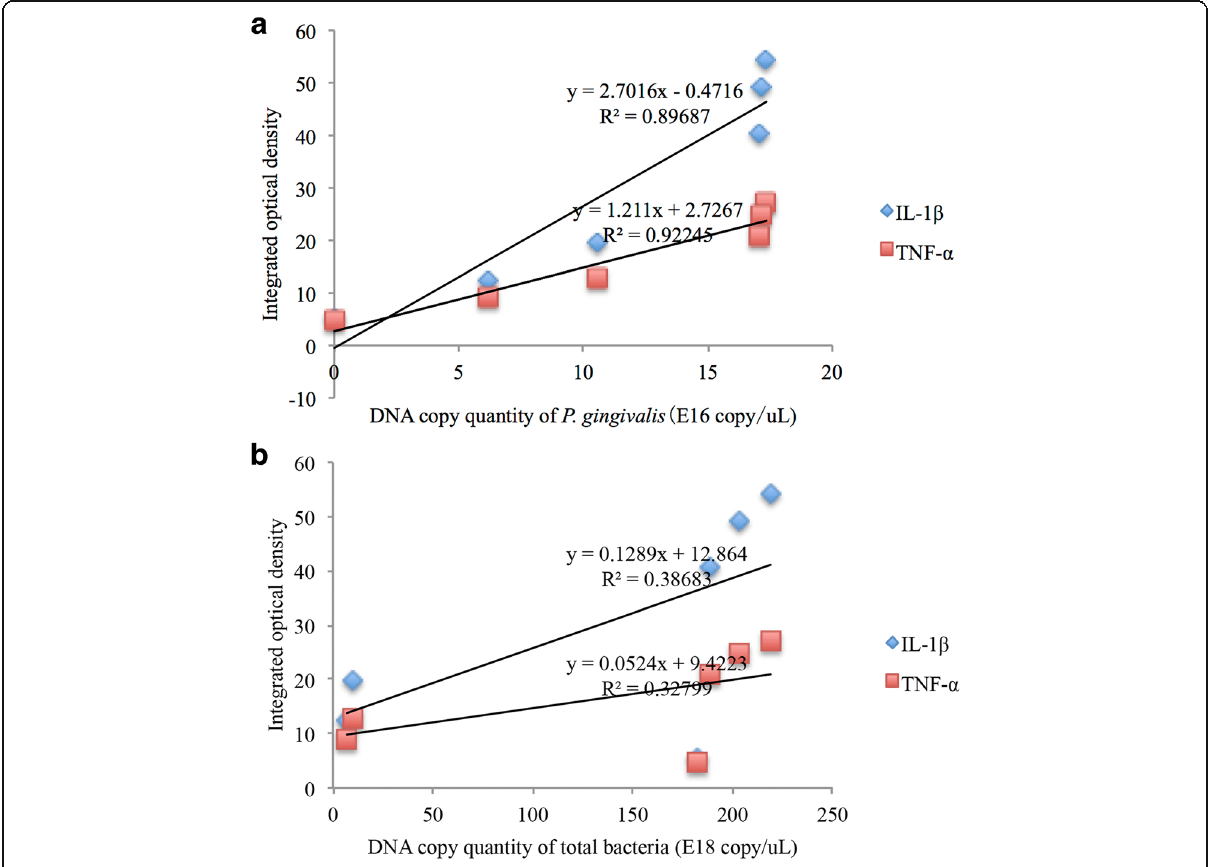
Fig. 4 a Linear correlation curve of the P. gingivalis ’ DNA copy number and cytokines in periodontal tissue (IL-1 β and TNF- α ). The integrated optical densities of IL-1 β and TNF- α were calculated on the basis of immunohistochemical staining. The levels of IL-1 β and TNF- α in rat periodontal tissue showed a significant positive linear correlation with DNA copy number of P. gingivalis ( P < 0.05). b Linear correlation curve of the total bacteria DNA copy number and cytokines in periodontal tissue (IL-1 β and TNF- α ). The integrated optical densities of IL-1 β and TNF- α were calculated on the basis of immunohistochemical staining. There was not a significant positive linear correlation between IL-1 β or TNF- α expression levels in rat periodontal tissue and DNA copy number of total bacteria ( P >